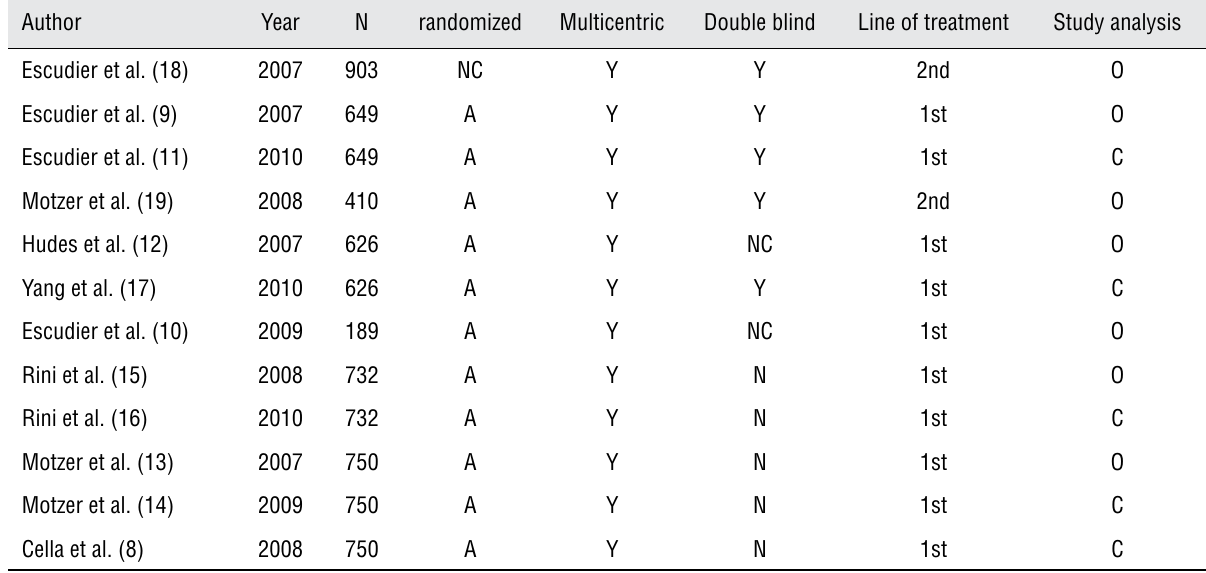
Table 1 - Metodological characteristics of the included